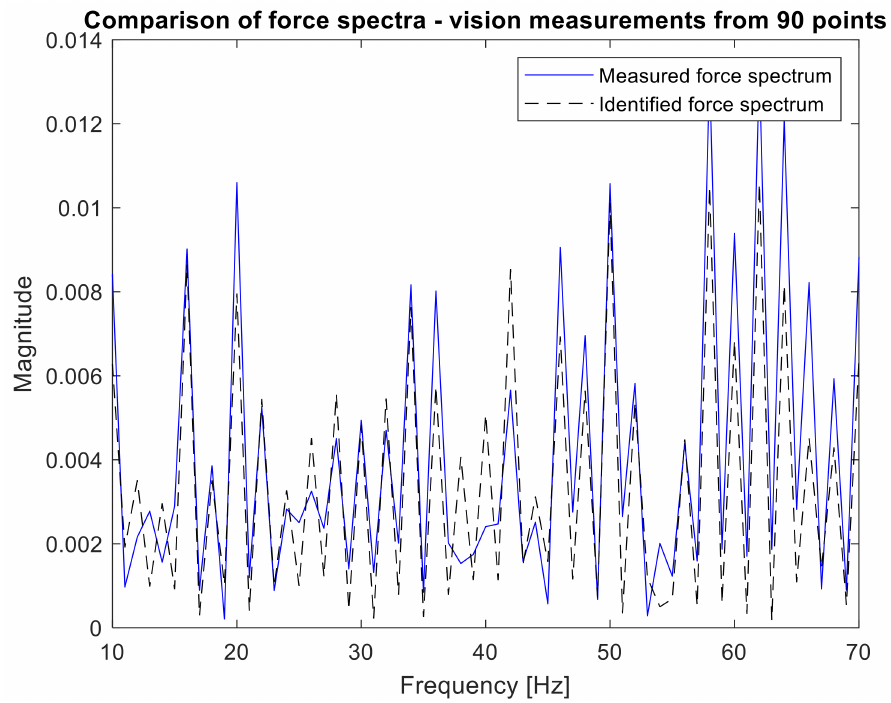
Figure 13. Comparison of measured and identified force spectra for the camera measurements (90 points—narrowed frequency